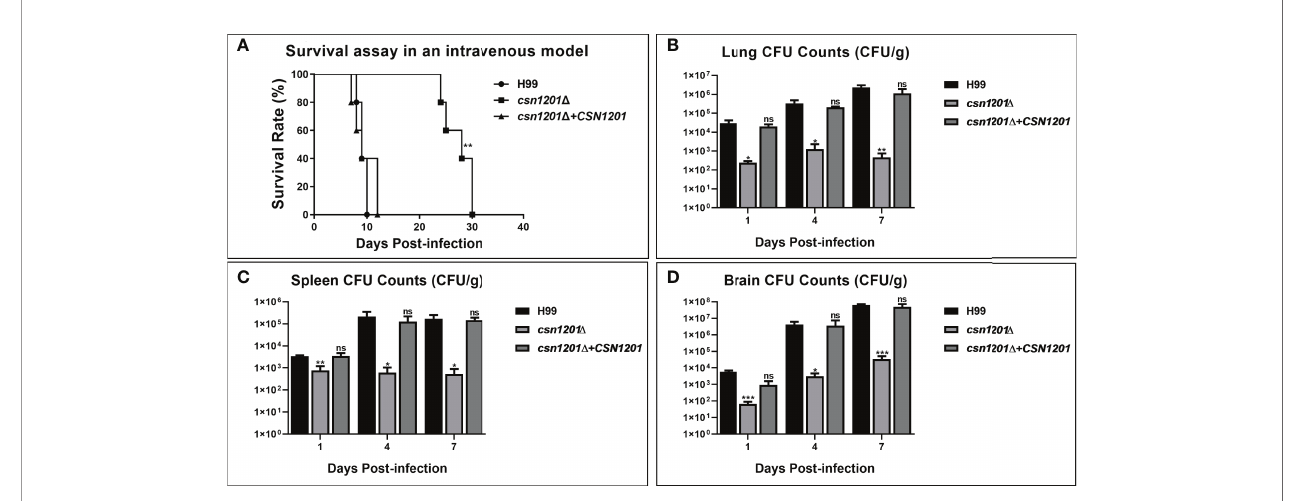
FIGURE 6 | The CSN1201 deletion attenuates virulence of C. neoformans in a murine intravenous model. (A) Survival assay in mouse intravenous cryptococcosis with different strains. Fungal burden assays in the lung (B) , spleen (C) , and brain (D) . Organs were removed at 1, 4, and 7 days post-infection in the three groups.